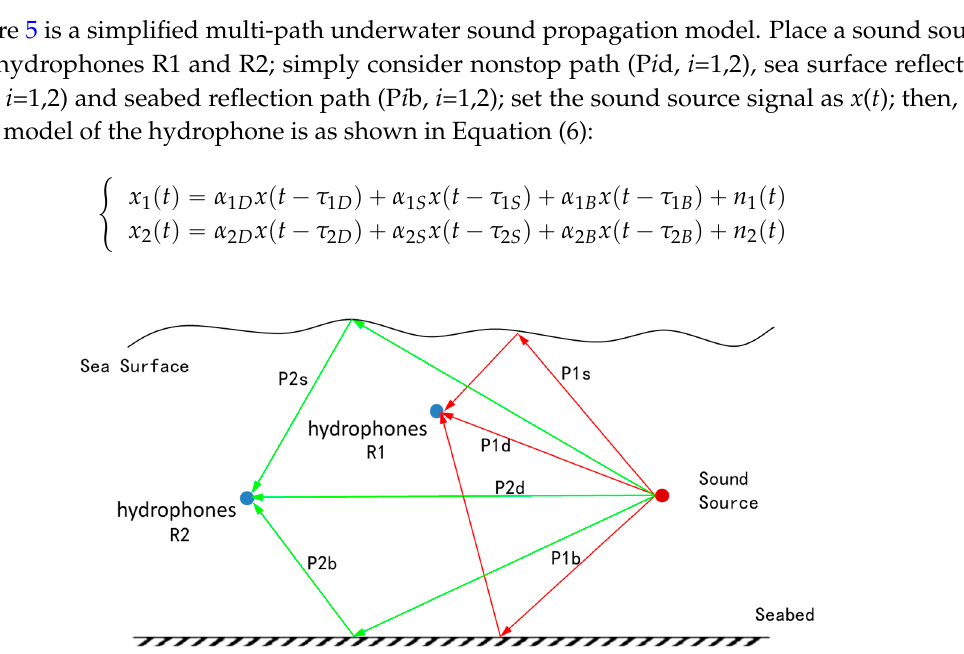
Figure 5. Simplified model of the underwater multi-path effect.